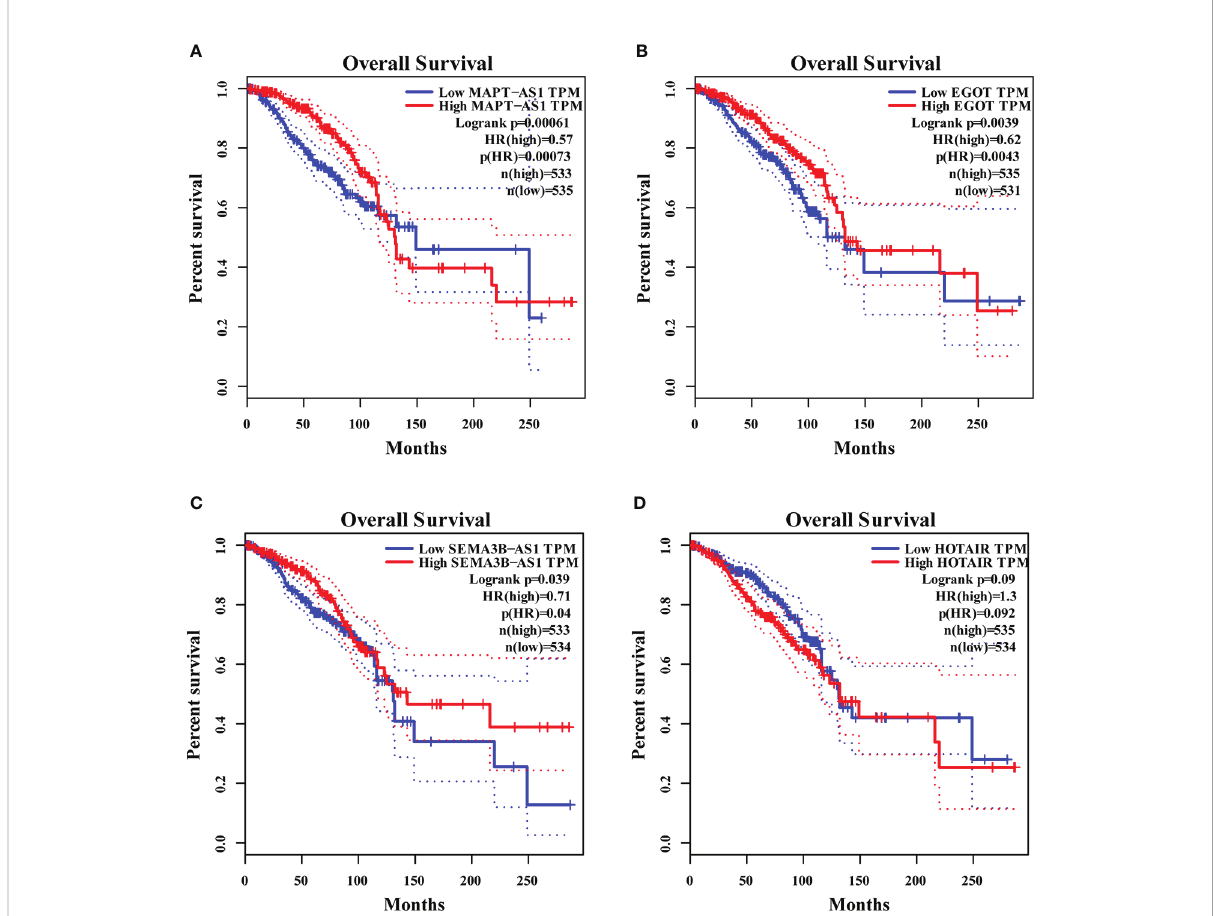
FIGURE 7 The overall survival analyses of MAPT-AS1, EGOT, SEMA3B-AS1, and HOTAIR on the online web, GEPIA. The high expression of MAPT-AS1 (A) , EGOT (B) , and SEMA3B-AS1 (C) predicts favorable survival, while the low HOTAIR (D) indicates favorable survival. GEPIA, gene expression pro fi ling interactive analysis; TPM, transcripts per